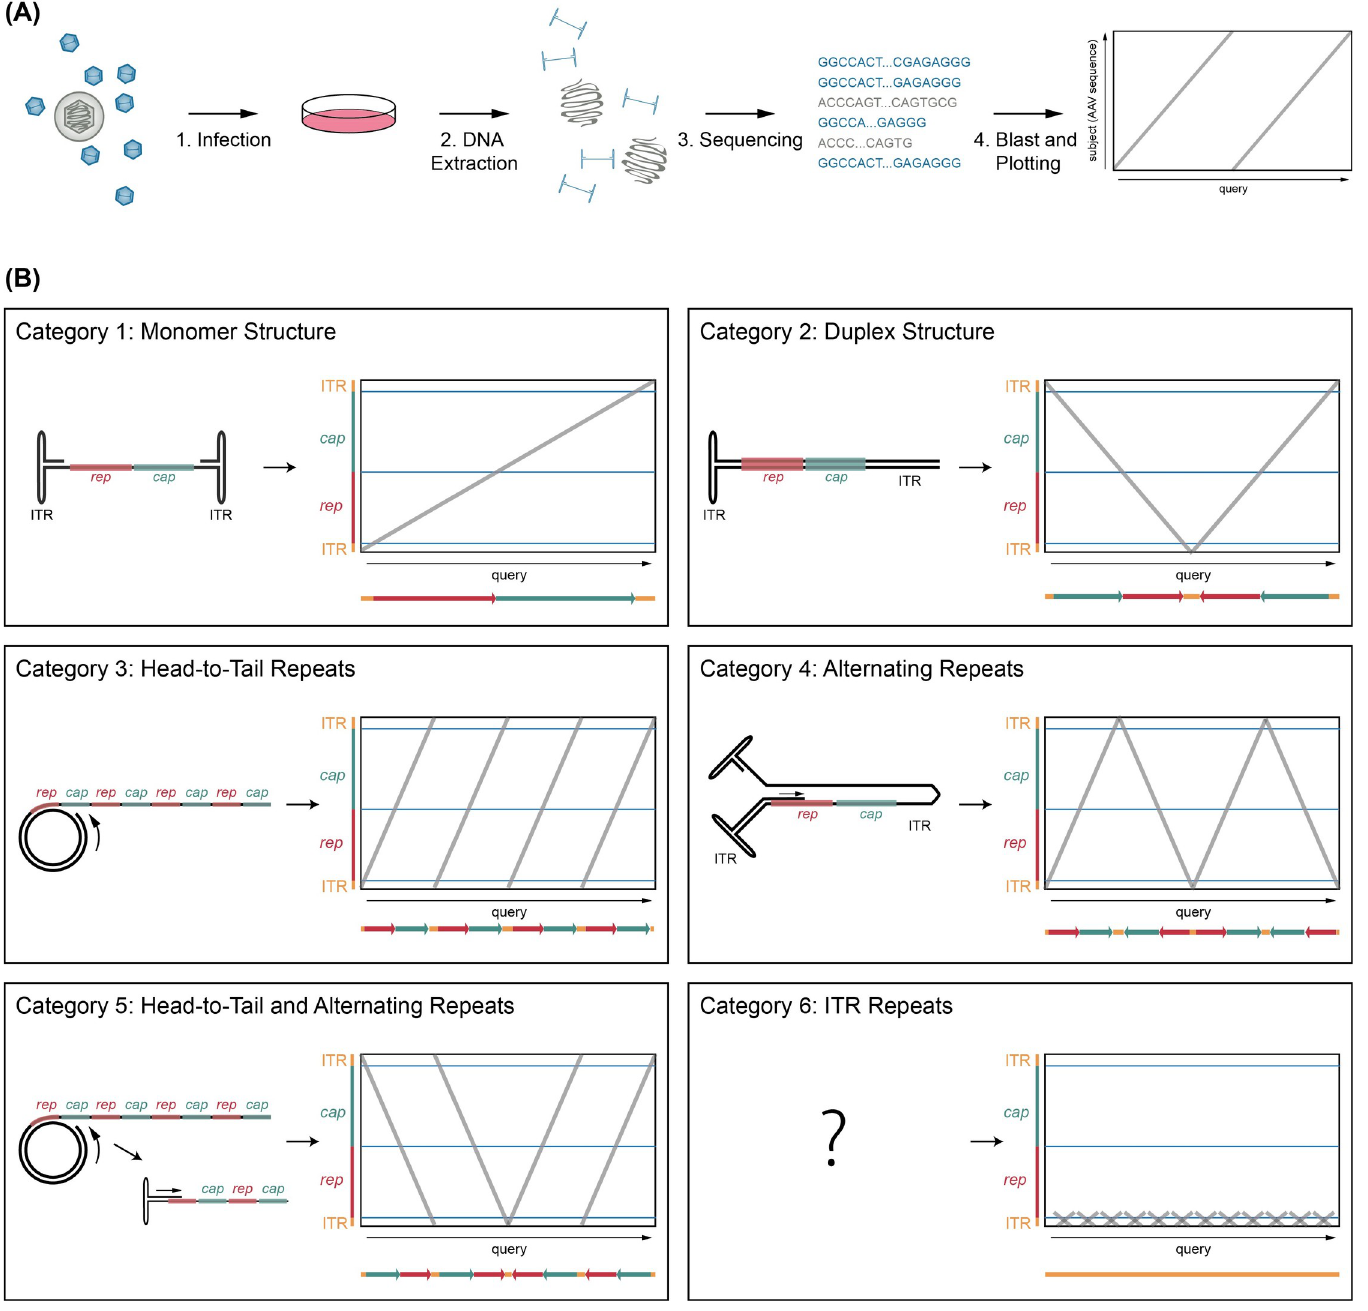
Fig 1. Experimental setup and definition of categories of AAV2 DNA replication products. (A) Schematic representation of the experimental setup. (B) Schematic representation of the defined categories with the predicted AAV DNA structure on the left and the corresponding theoretical dot plot on the right. Dot plots were used to visualize the AAV sequence from isolated genomes with the read (query) on the x-axis and the location on the AAV genome on the y-axis. For further clarification, the read sequence is shown below the dot plot. The AAV ITR-ends (orange) and the genome coding regions rep (red) and cap (green) are indicated. Of note, only one orientation is shown per category although both orientations are